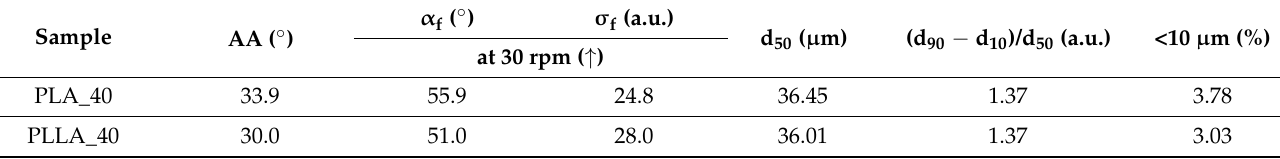
Figure 2. Cumulative distribution and distribution density of PLA and PLLA. Table 1. F irst avalanche angle (AA), flowing angle (α f ), cohesive index (σ f ), and particle size distribution of the prepared PLA and PLLA powders Sample